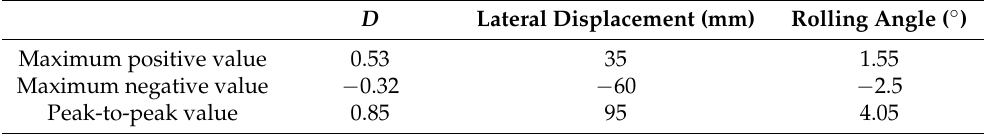
Figure 19. Dynamic response time history: ( a ) side force ( Fy ), ( b ) overturning coefficient ( D ), ( c ) lateral displacement, and ( d ) the rolling angle of the car body centre. Table 4. Value of the maximum dynamic responses.